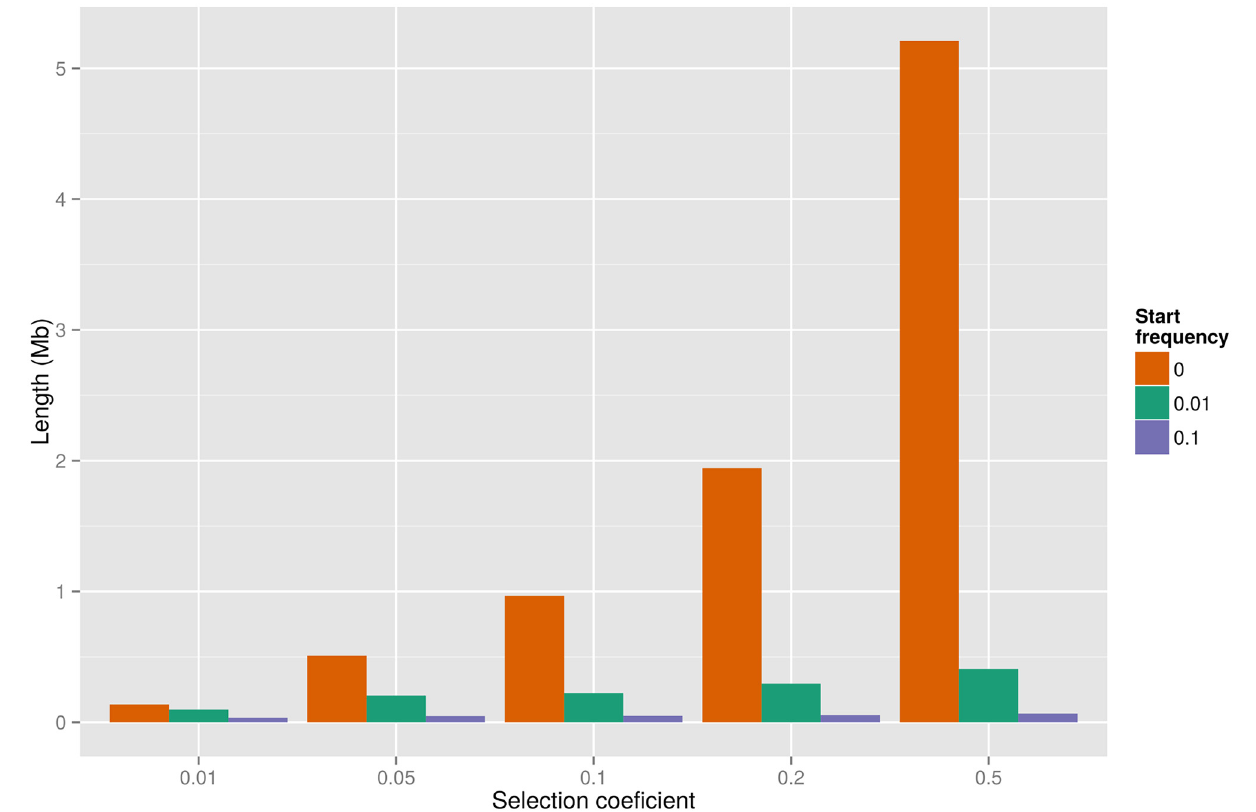
Fig 4. Expected genetic length of the region with less than 5% ILS surrounding a selected mutant with given selection coefficient and start frequency. Lengths are provided assuming a recombination rate of 1 cM/Mb.